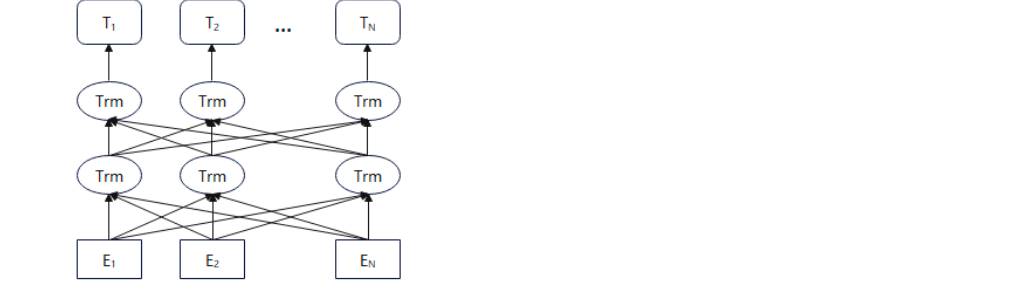
Figure 1. Structure of BERT model. Where E 1 , E 2 , . . . , E N represents the pre-processed text input, T 1 , T 2 , . . . , T N represents the vector output trained by the BERT model. The Trm module is an Encoder structure from Transformer.